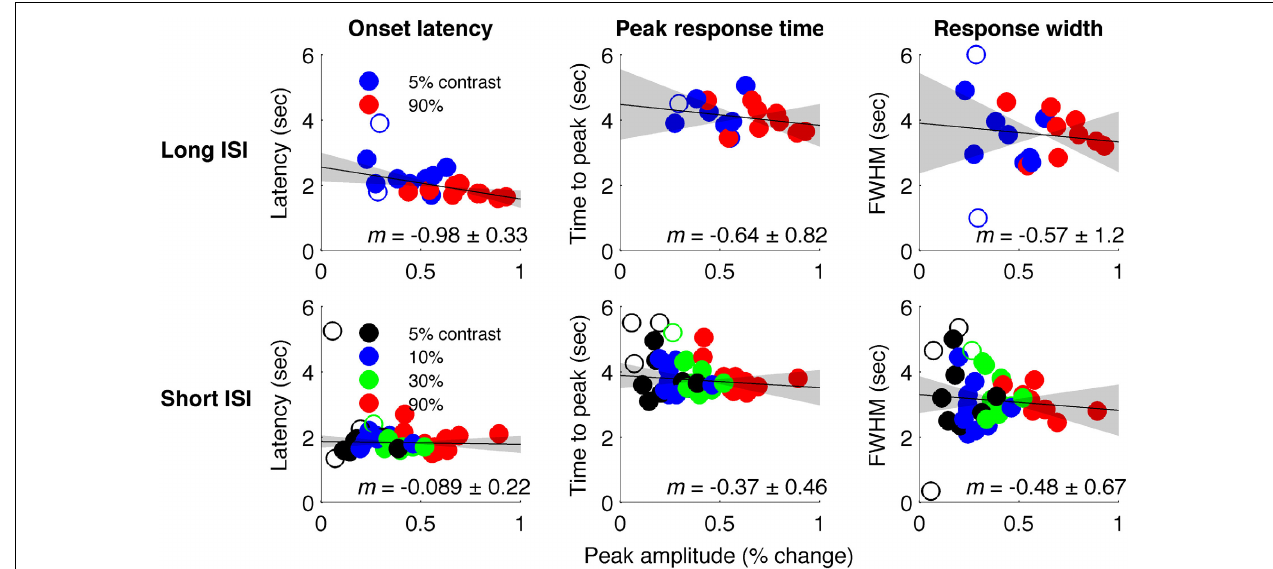
FIGURE 4 | Timing parameter estimates for individual HRFs. Top: Long-ISI data. Bottom: Short-ISI data. Columns plot (left to right) onset, peak, and FWHM vs. amplitude. Slope (solid line) and 95% confidence interval (gray shading) for robust regression are displayed on each plot.